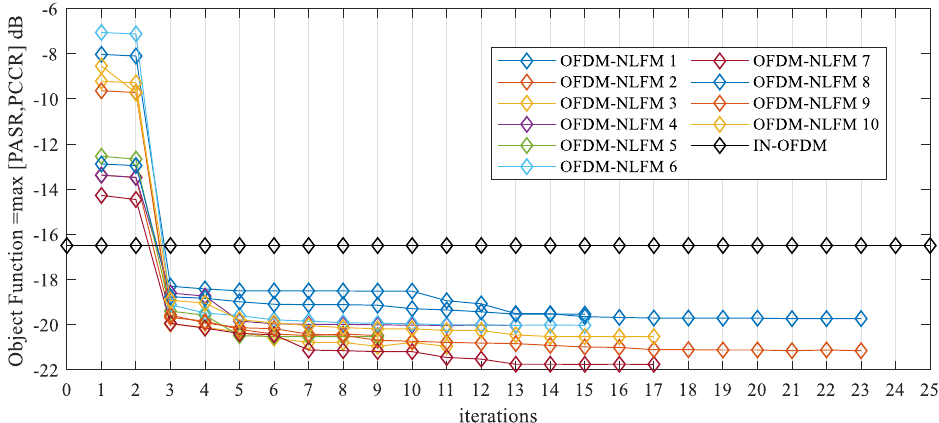
Figure 10. Convergence curve of objective function of OFDM-NLFM waveform set when randomly initialized.